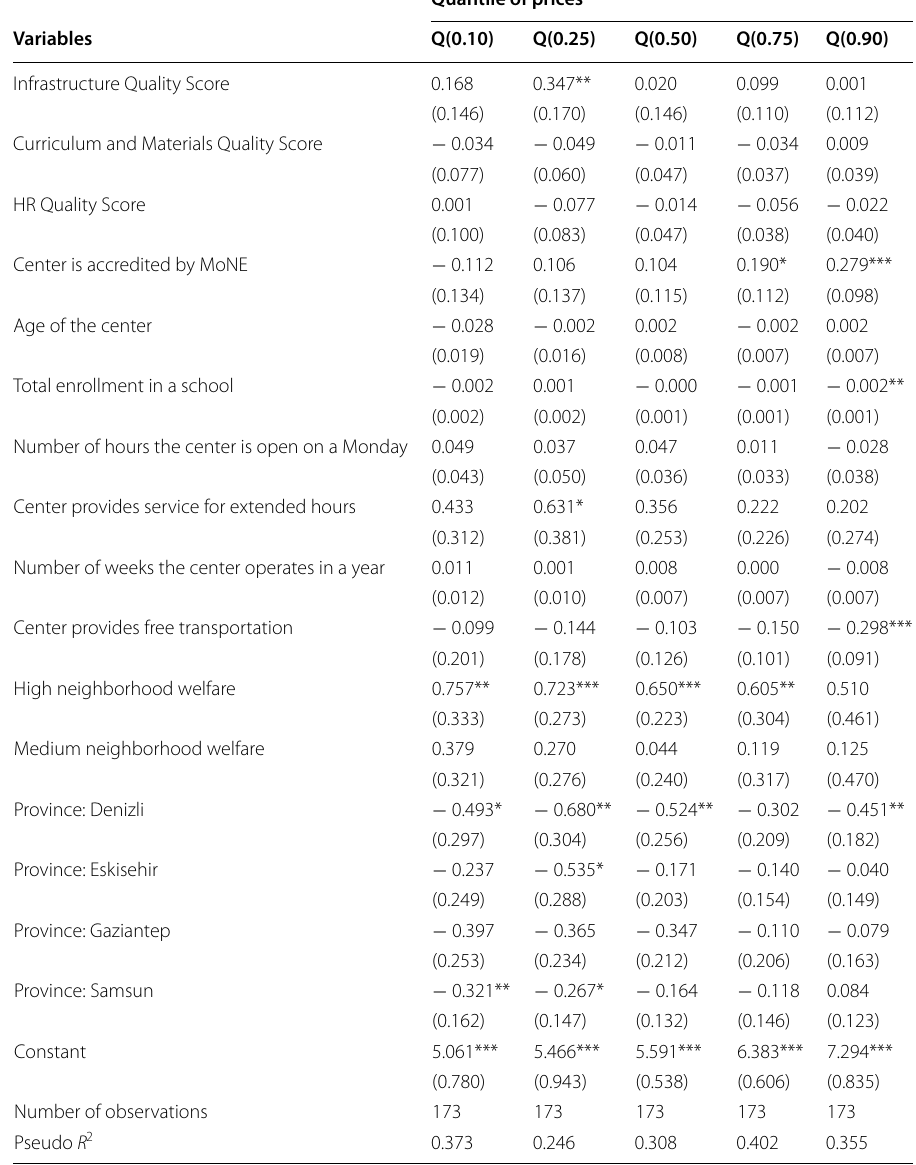
Table 5 Quantile regression results for the price equation with province